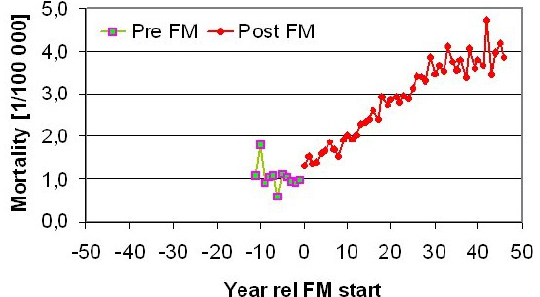
Figure 8. Melanoma mortality in Swedish counties related to the year they got FM radio broadcasting (from 1955 to 1965). From [7], with permission to